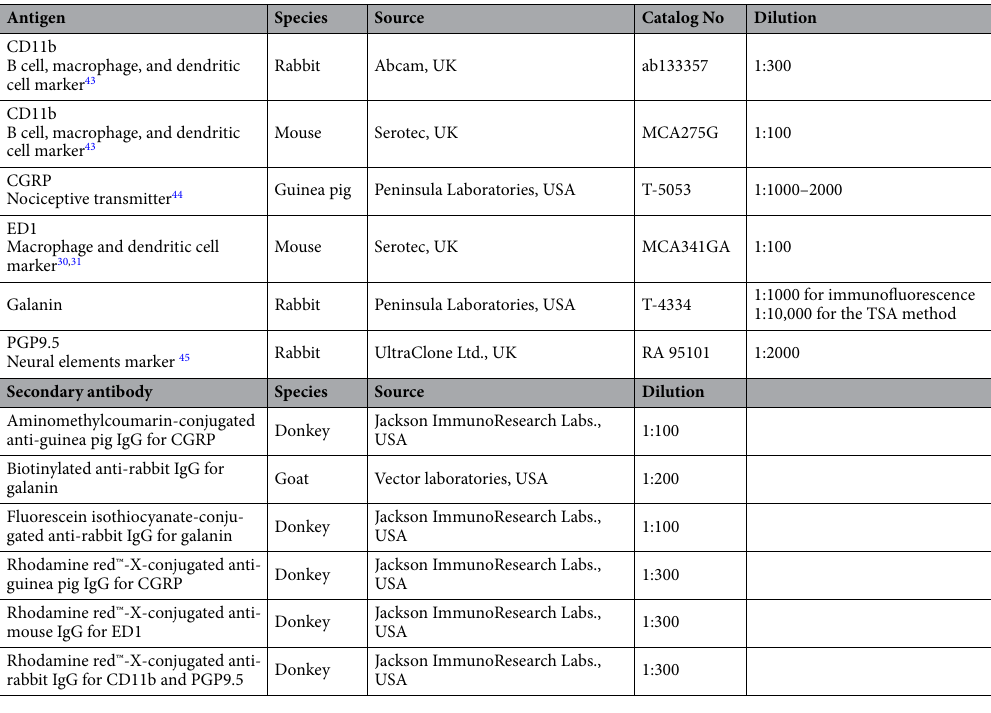
Table 1. Primary and secondary antibodies used in this